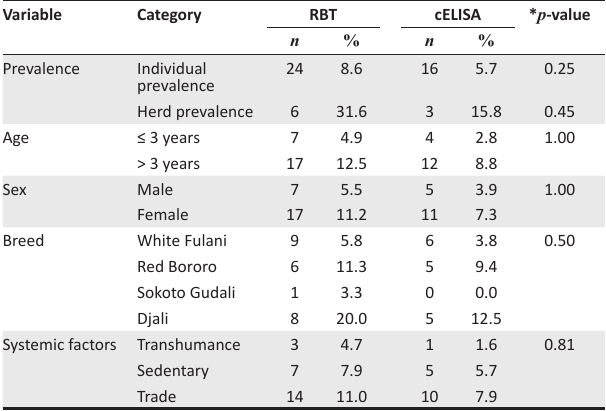
TABLE 2: Risk factors associated with seroprevalence of bovine brucellosis as measured by the Rose Bengal test and competitive enzyme-linked immunosorbent assay in three cattle production systems in Yewa Division,